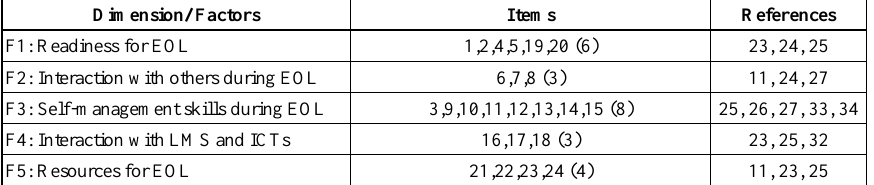
Table 1. Structure for the construction of instrument dimensions and